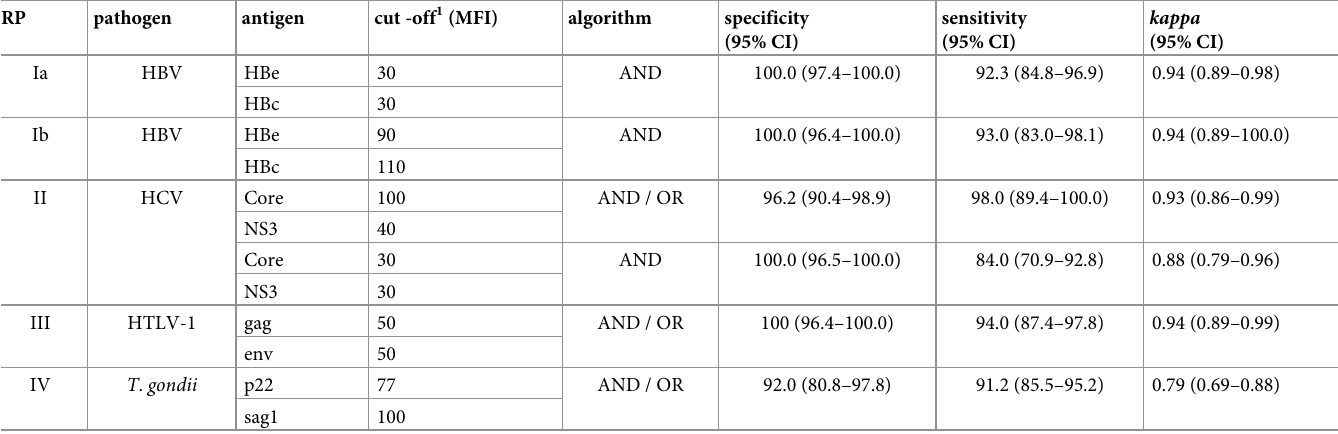
Table 4. Overall pathogen-specific statistical performance in Monoplex Serology in corresponding reference